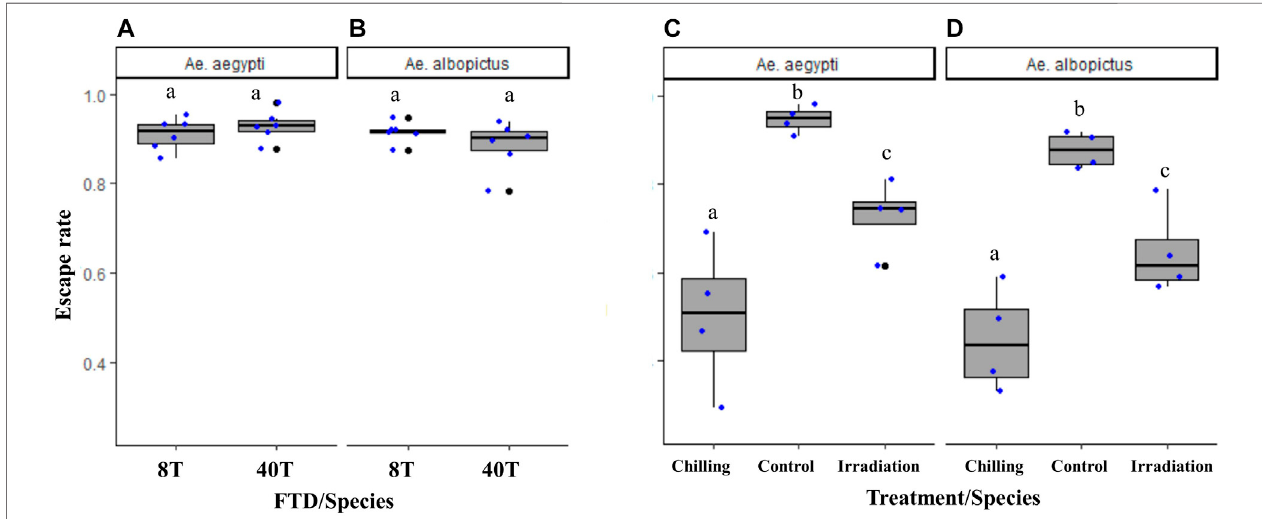
FIGURE 8 | Escape rates of male Aedes aegypti (A) and Aedes albopictus (B) in eight-tube FTD ( “ 8T ” : version 2.0) versus 40-tube FTD ( “ 40T ” : version 1.1) and effects of cold stress ( “ chilled ” ) and high-dose irradiation (150 Gy, GammaCell and 100 Gy, X-ray, Raycell) on male Aedes aegypti (C) and Aedes albopictus (D) fl ight ability,respectively,usingtheeight-tubeFTD.Blackbarsindicatethemedian;theupperandlowerlimitsofeachboxindicatetheinterquartilerange.Eachdotrepresents a value of the observed escape rate per replicate. Different letters denote signi fi cant differences between FTDs and treatments.